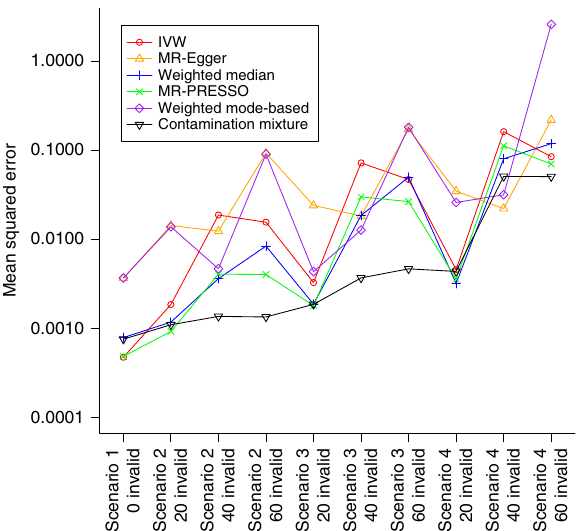
Fig. 1 Comparison of the methods based on mean squared error criterion. The mean squared error of the various methods is plotted in each scenario with a null causal effect. The corresponding plot with a positive causal effect was practically identical. The contamination mixture method has the best overall performance according to this measure, particularly in scenarios where 40 or 60 out of the 100 genetic variants were invalid instruments. The vertical axis is plotted on a logarithmic scale.